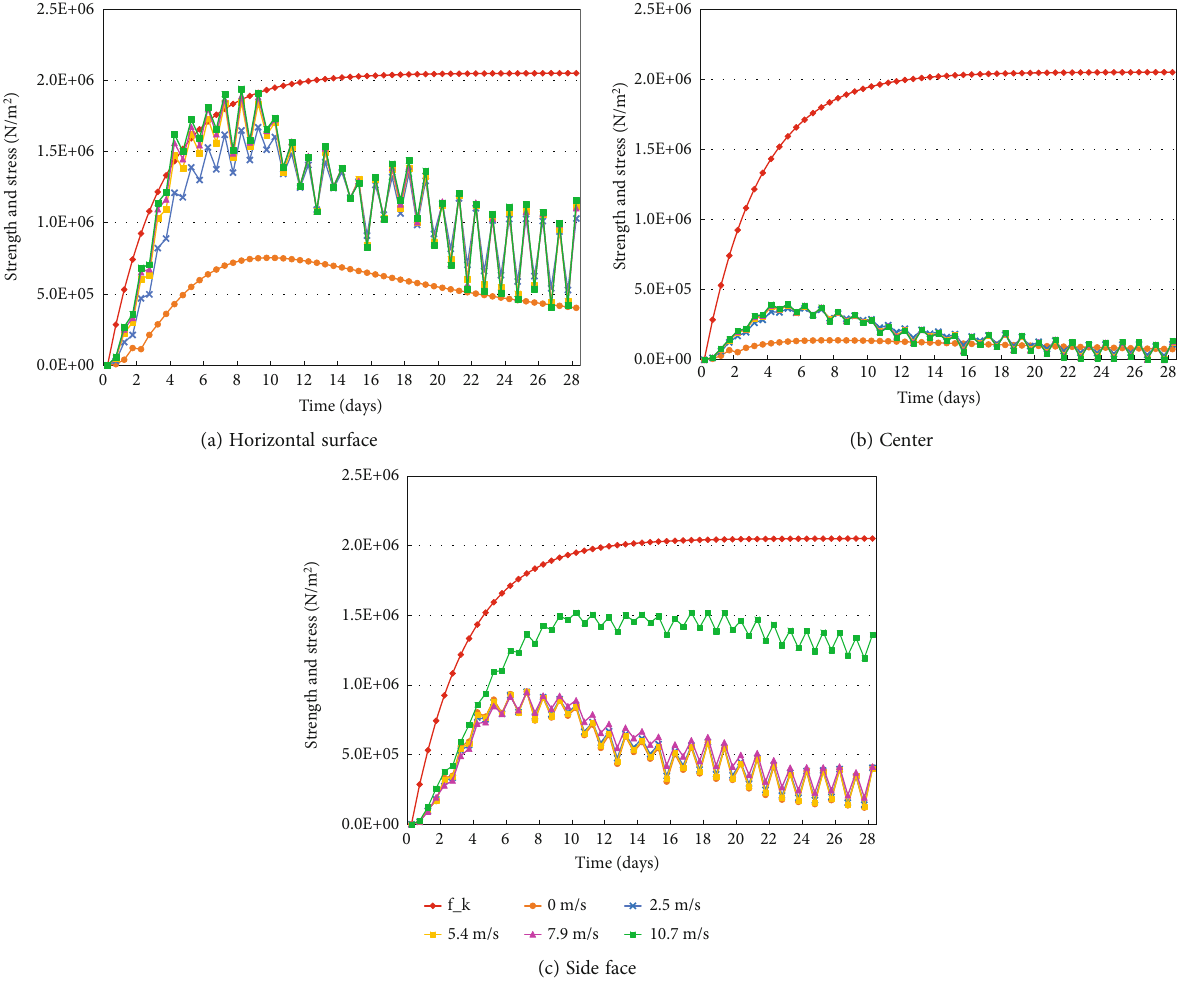
Figure 8: Maximum temperature stresses of concrete under di ff erent wind